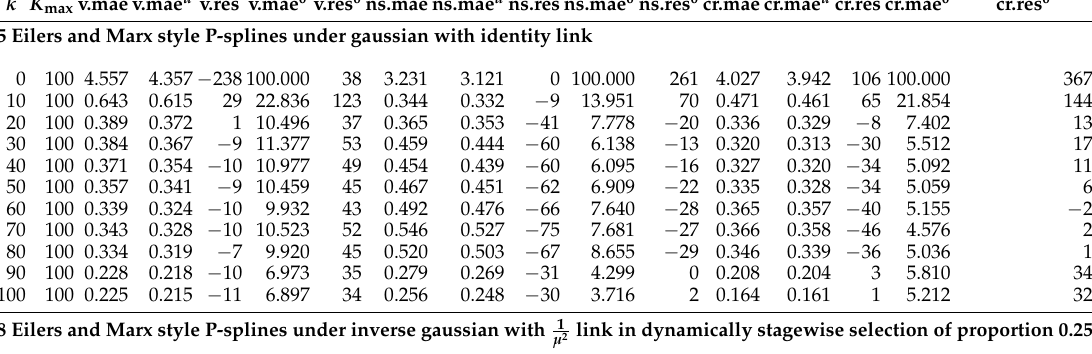
Table A22. Out-of-sample validation figures of selected GAMs of BEL with varying spline function number per dimension and fixed spline function type under between 91–443 and 150–443 after each tenth and the finally selected smooth function or after each dynamically stagewise selected smooth function block. Thereby furthermore a variation in the random component link function